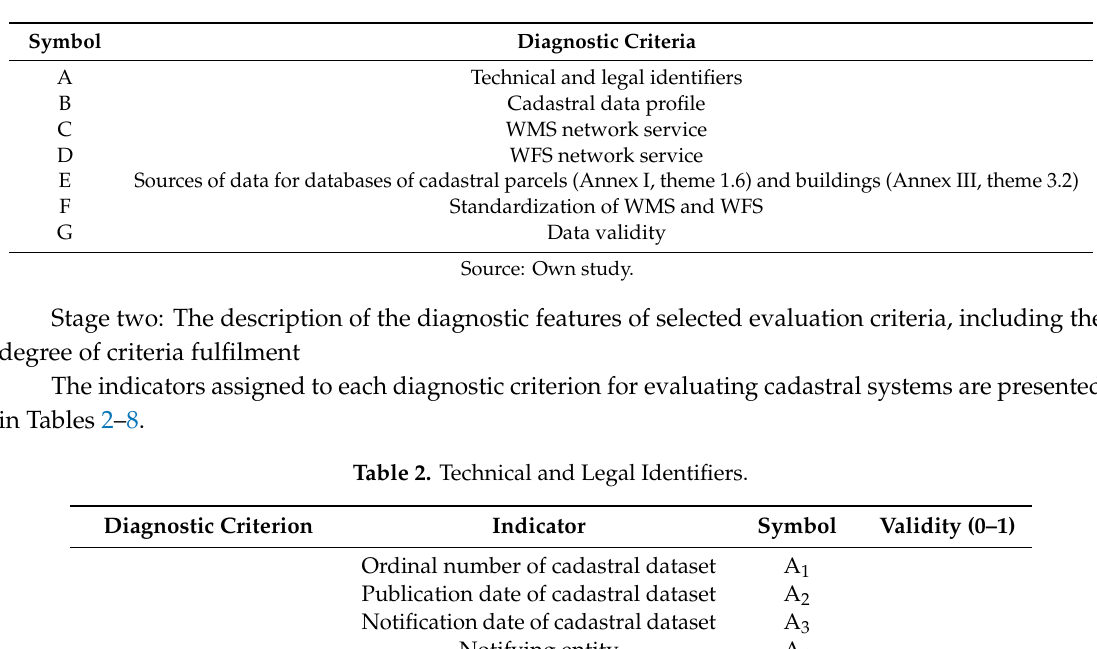
Table 1. Selected Diagnostic Criteria for Evaluating Cadastral Systems. WMS: Web Map Service; WFS: Web Feature Service.